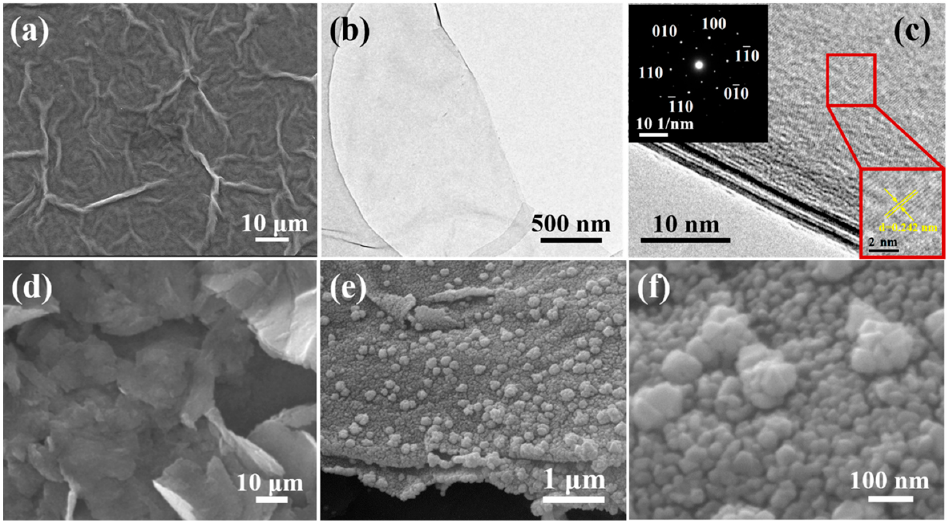
Figure 1. ( a ) SEM, ( b ) TEM, and ( c ) HRTEM images of f-MXene. SEM images of ( d ) MXene@PANI and ( e , f ) Au- β -CD/MXene@PANI.